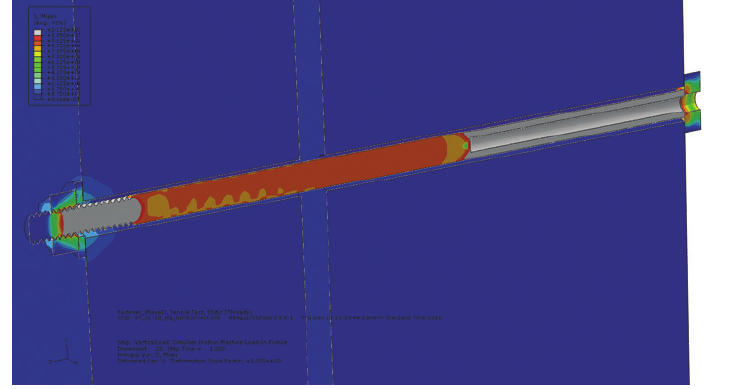
Fig. 7. Contours of von Mises stresses at maximum applied displacement, static tension